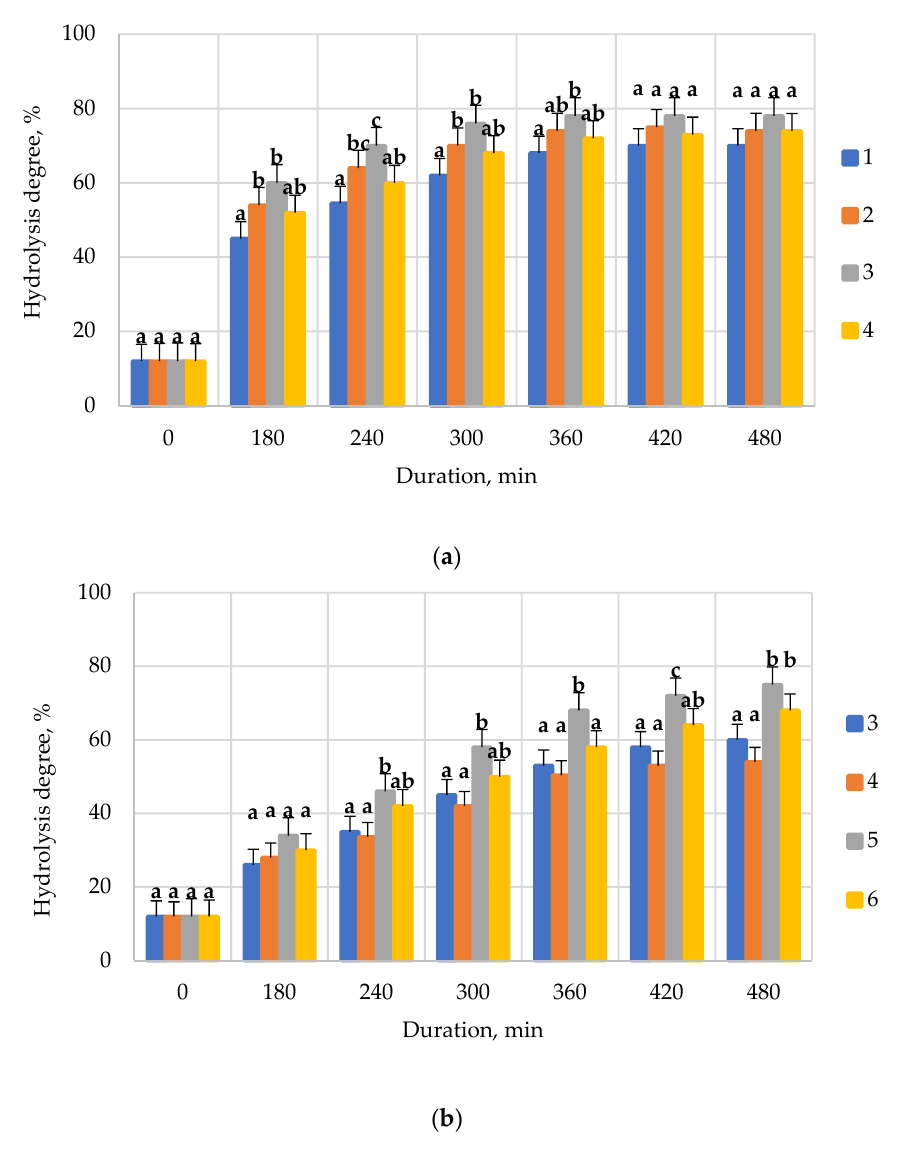
Figure 3. Results of studying the biodegradation of protein molecules of samples of collagen-con- taining raw materials by ( a ) collagenase or ( b ) Neutrase 1.5 MG at different temperatures, °C: 1–30; 2–35; 3–40; 4–45; 5–50; 6–55. Values followed by the same letter do not differ significantly ( p > 0.05) as assessed by post hoc test (Tukey test).